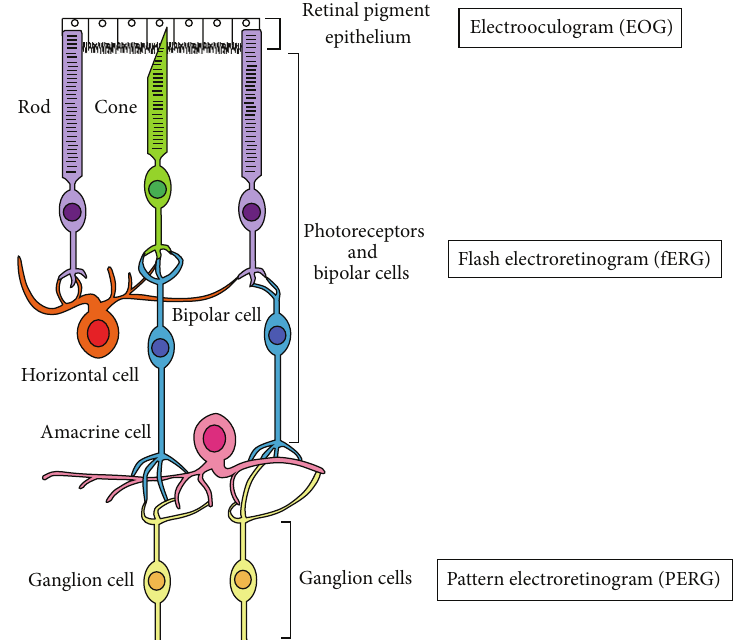
Figure 1: Schematic representation of the retina and standardized electrophysiological methods allowing the assessment of the retinal